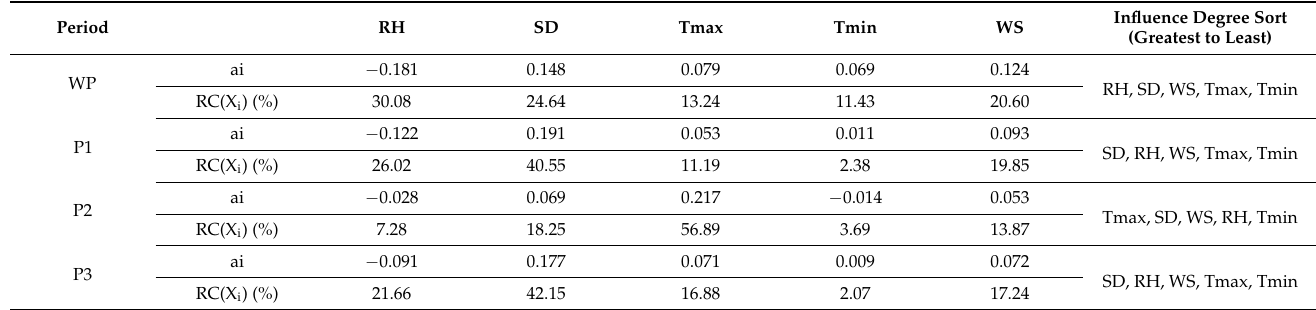
Table 2. Multiple linear regression coefficients (ai) and relative contributions (RC(X i )) of climatic factors to ETo for the whole THM during different